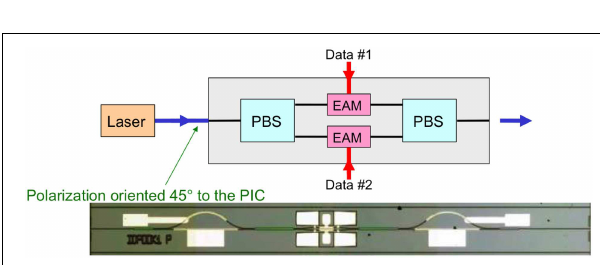
FIGURE 17 | 80-Gb/s dual-polarization transmitter in InP. It consists of two electro-absorption InGaAsP modulators, a polarization splitter, and a polarization combiner. The incoming laser has its polarization oriented at 45 ◦ .